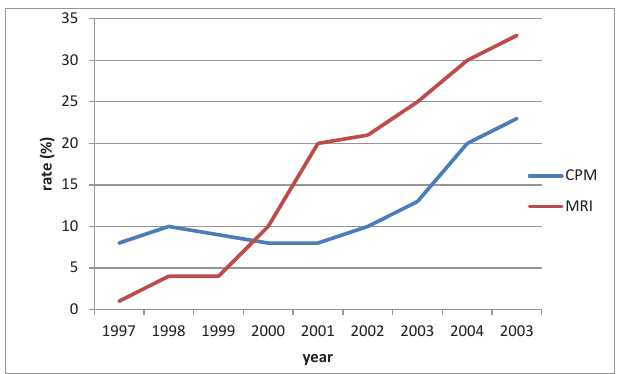
Fig. 1. The relationship between MRI usage and CPM rates and use of MRI at diagnosis by year of surgery (based on data from King et al .) 14